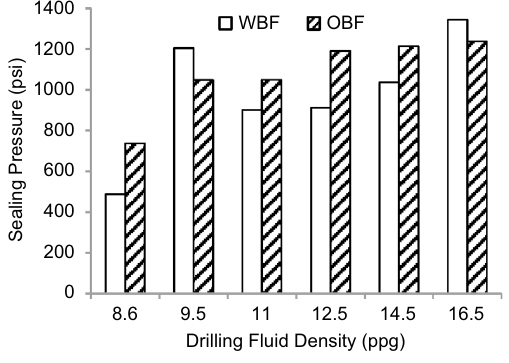
Fig. 6 Effect of adding three ranges of sieved barite particles on the sealing pressures of 12.5 ppg OBF treated with G and SCC #1 at 30 ppb. Variation of barite particle sizes causes the sealing pressures to be varied from 1073 to 1249